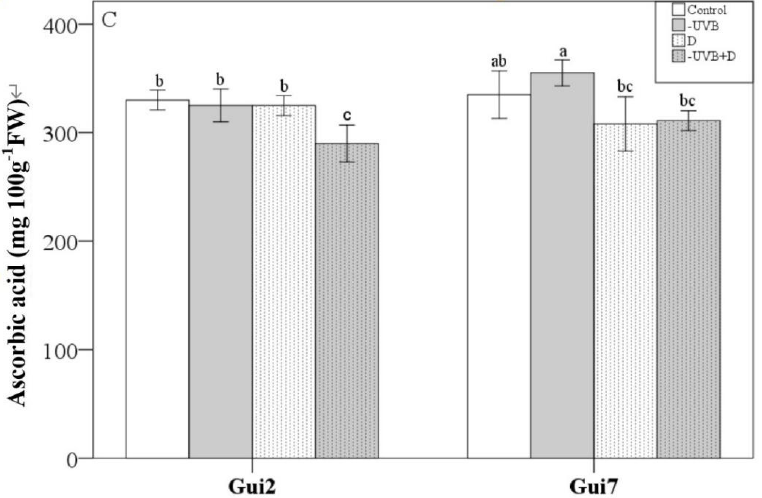
Figure 2. Leaf electrolyte conductance ( A ), leaf proline concentration ( B ) and leaf total ascorbic acid concentration ( C ) of two Chestnut rose cultivars under different water regimes and solar UV-B treatments. Values are mean ± SD. Different letters above the bars indicate the significant difference between treatments at p < 0.05 level by LSD pairwise comparisons. Control, ambient UV-B; –UV-B, UV-B exclusion; D, drought with ambient UV-B; –UV-B+D, drought with UV-B exclusion. Table 1. F ‐ values and significance levels for three ‐ way ANOVAs of the effect of cultivar, drought, UV ‐ B, and their interaction on growth and physiological properties in Chestnut rose. C, cultivar; D, drought; U, UV ‐ B. P/S ratio, leaf palisade/spongy tissue ratio; EC, leaf electrolyte conductance; Asa, leaf total ascorbic acid concentration. ns, not significant.